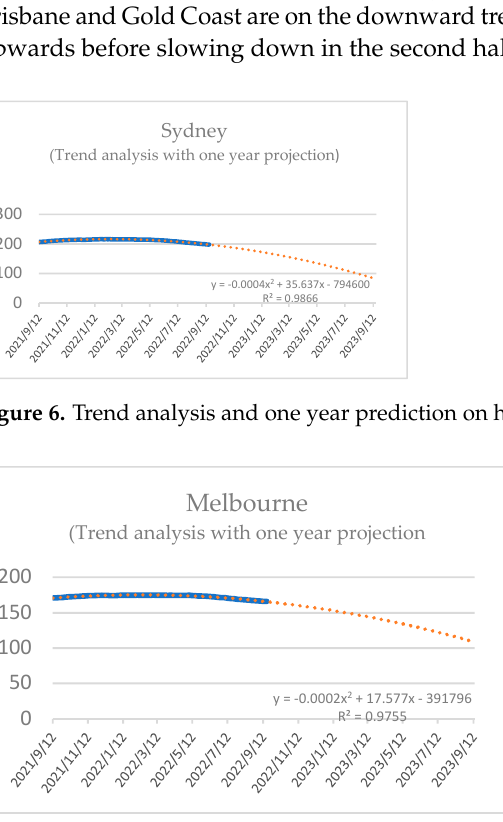
Figure 7. Trend analysis and one year prediction on housing prices for Melbourne.